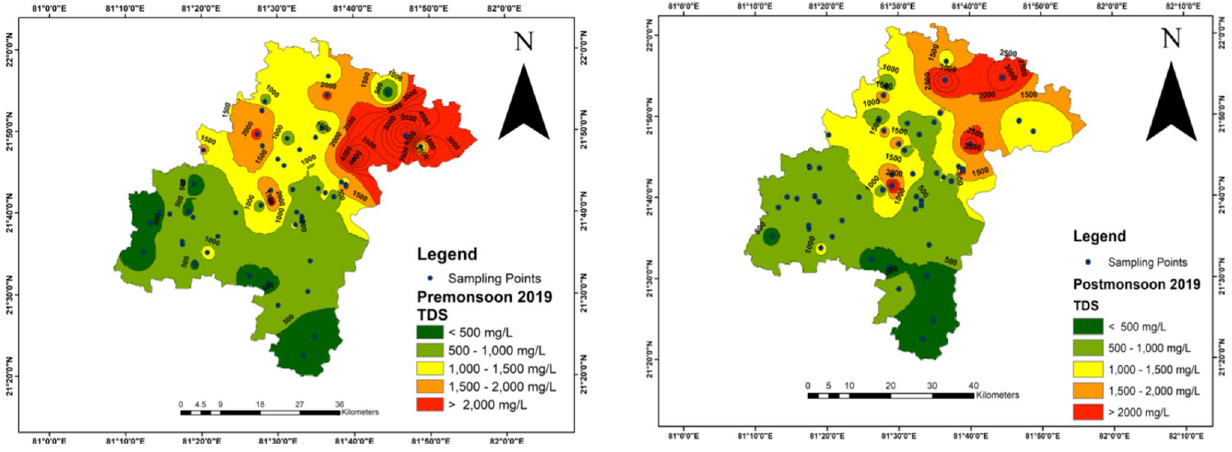
Fig. 4 Spatial distribution of TDS in the groundwater of the study area (pre- and post-monsoon